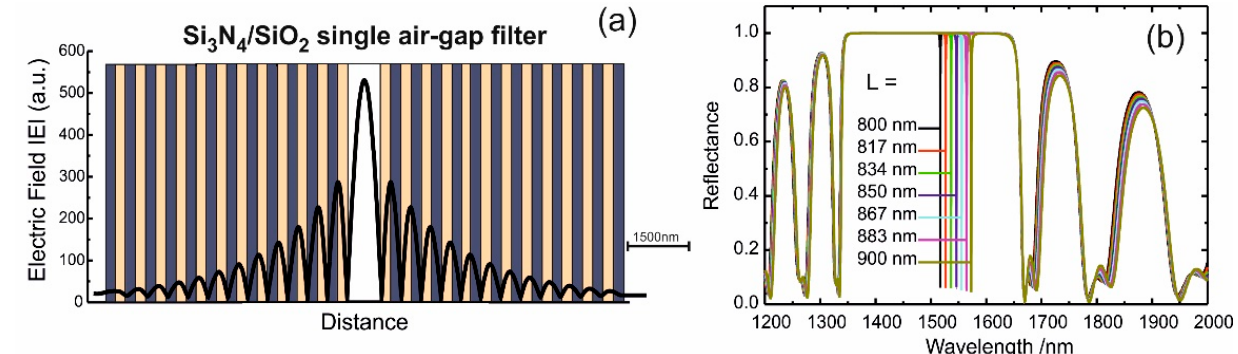
Figure 11. MEMS tunable FP filters with half-a-wavelength cavity and SiO 2 /Si 3 N 4 DBRs. ( a ) Cross section of the cavity embedded by dielectric DBRs together with the absolute value of the standing electrical field (black profile). ( b ) Corresponding reflectance spectra for different air-gap cavity widths L addressed by MEMS tuning.